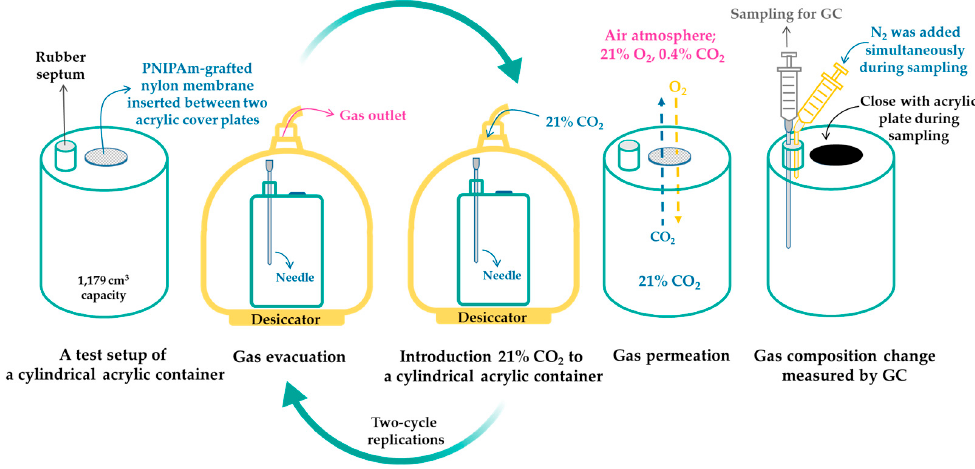
Figure 1. Schematic of gas - impermeable acrylic cylindrical container and gas permeation measure-